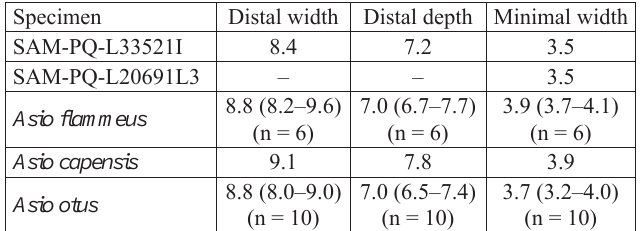
Table 10. Measurements (in mm) of the tibiotarsus of Asio sp. from Langebaanweg in comparison with corresponding measurements of extant Asio species; n, sample